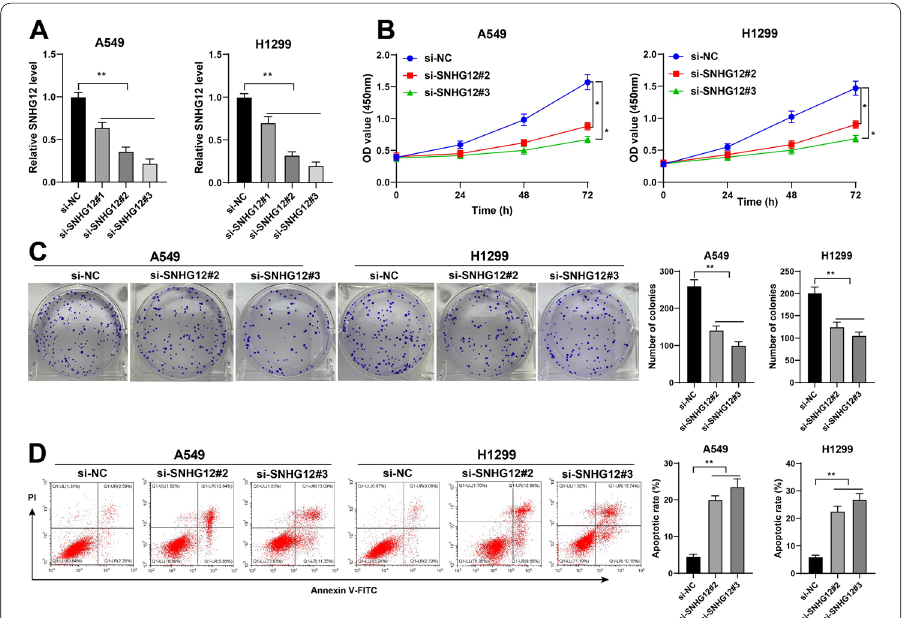
Fig. 2 lncRNA SNHG12 downregulation repressed proliferation and promoted apoptosis of NSCLC cells. A549 or H1299 cells were transfected with SNHG12 siRNA (si-SNHG12), with NC siRNA (NC siRNA) as the negative control. A lncRNA SNHG12 expression in NSCLC cells was measured via RT-qPCR; B‑C cell proliferation was assessed via CCK-8 and colony-formation assays; D apoptosis was assessed via flow cytometry.